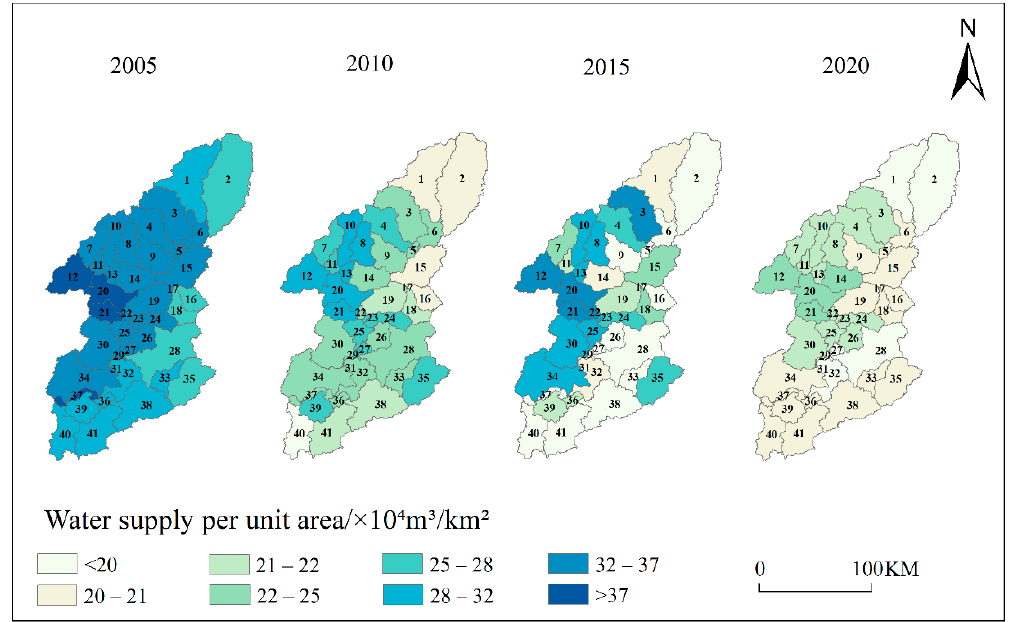
Figure 3. Spatial distribution of water supply per unit area in Dongjiang River Basin from 2005 to